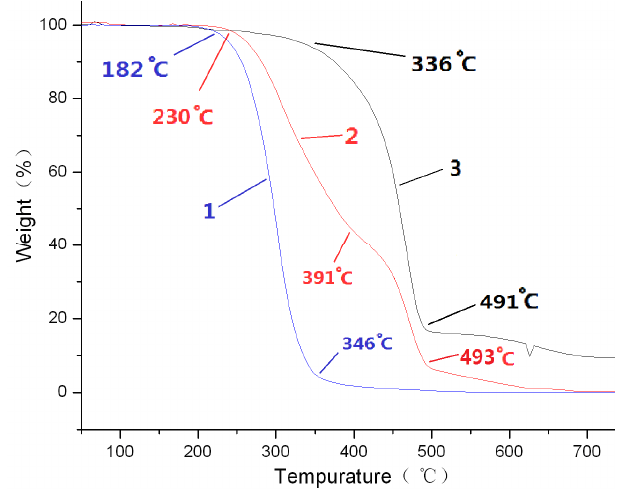
Figure 2. Thermal analysis curves of paraffin, pretreated paraffin and